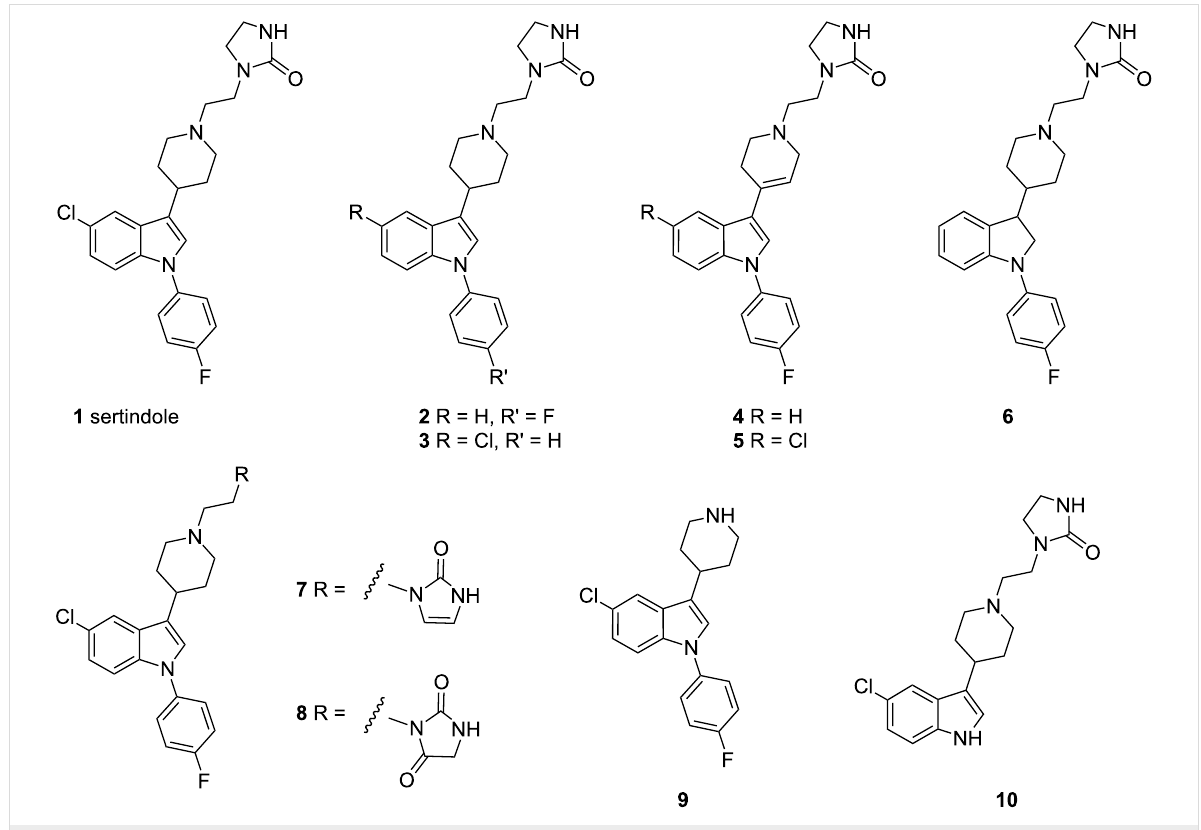
Figure 1: Sertindole ( 1 ), process related impurities and metabolites.